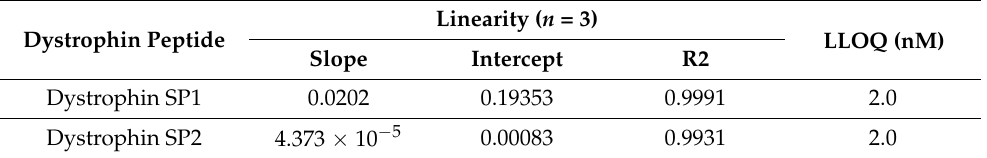
Table 2. Linearity and sensitivity summary over three days.